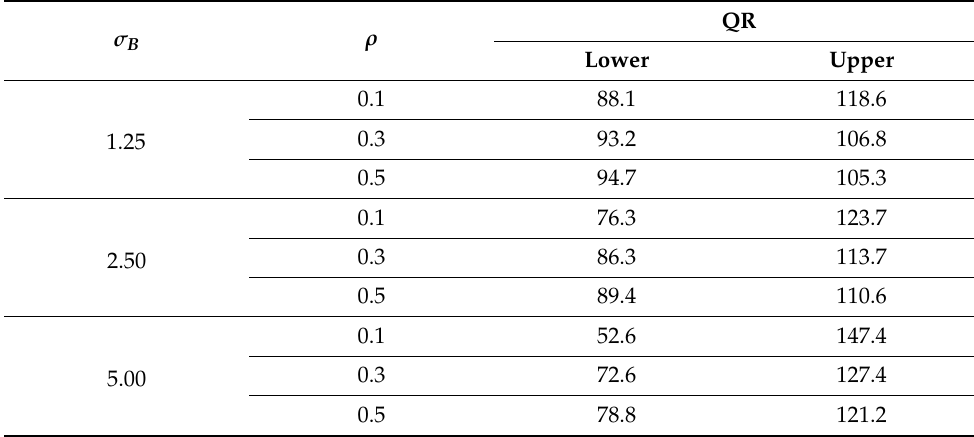
Figure 2. QR bounds distributions of stratified bootstrap samples and estimates with 95% confidence intervals for QR estimated from variance components. Table 4. QR values as a function of σ R and ρ for µ = 100 and k =